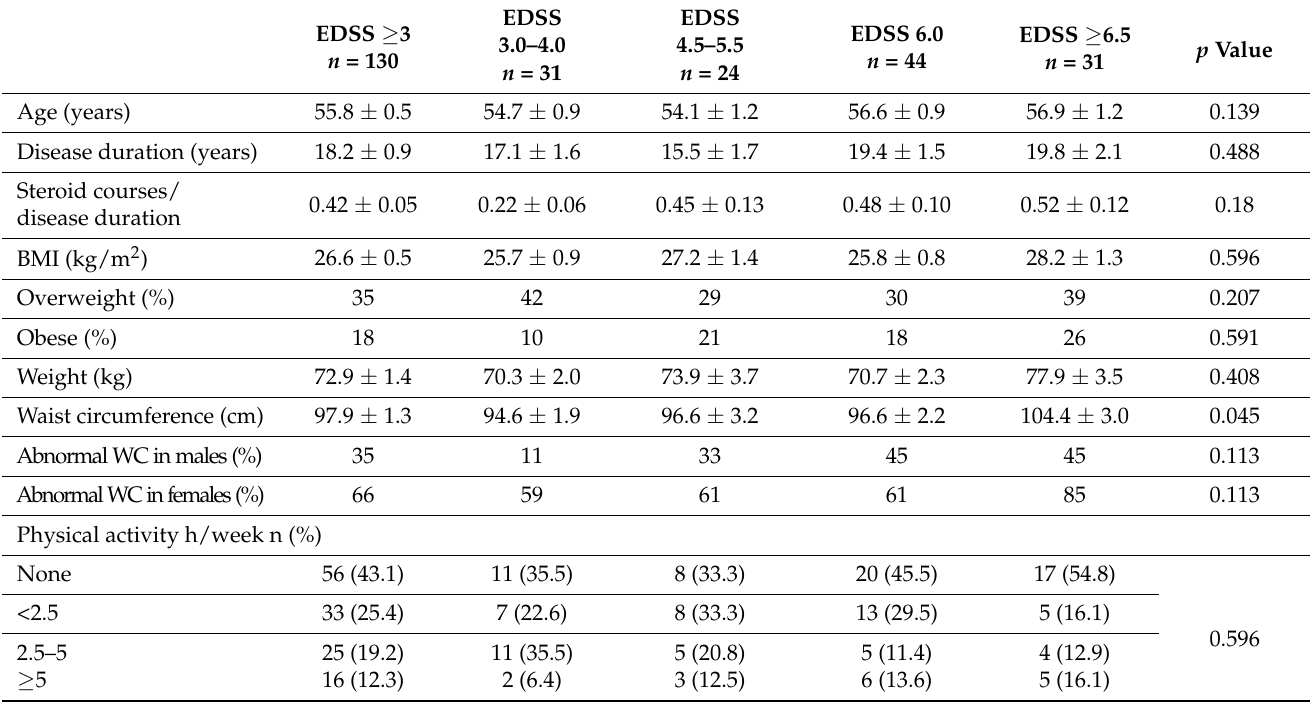
Table 1. Characteristics of individuals with multiple sclerosis according to the different Expanded Disability Status Scale (EDSS)